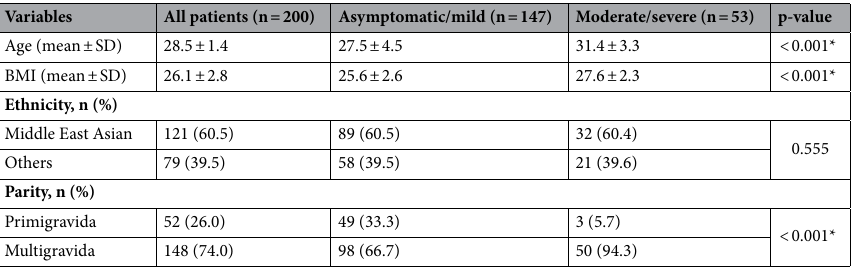
Table 1. Demographic characteristics of the infected pregnant women with COVID-19. *Significance at p-value <